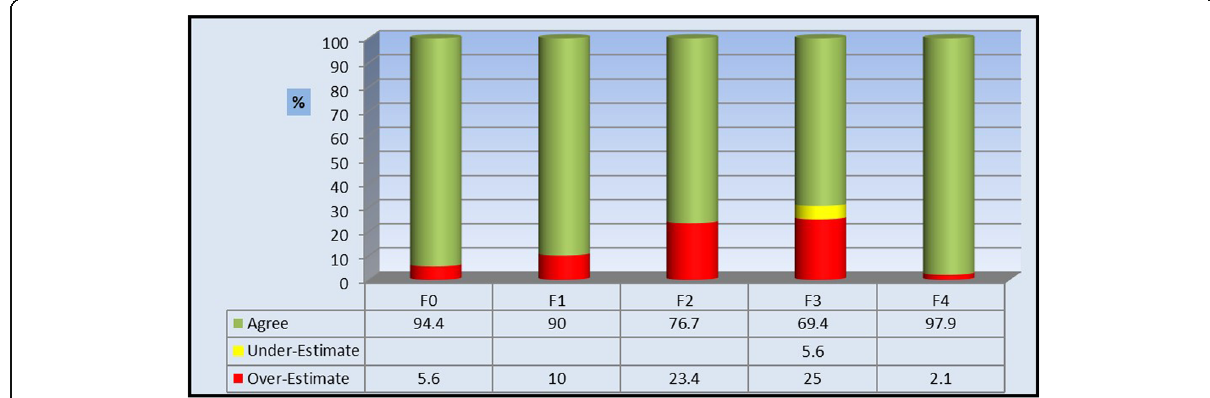
Fig. 2 The degree of agreement and the mismatch incidence between the SWE fibrosis score compared to the fibroscan fibrosis